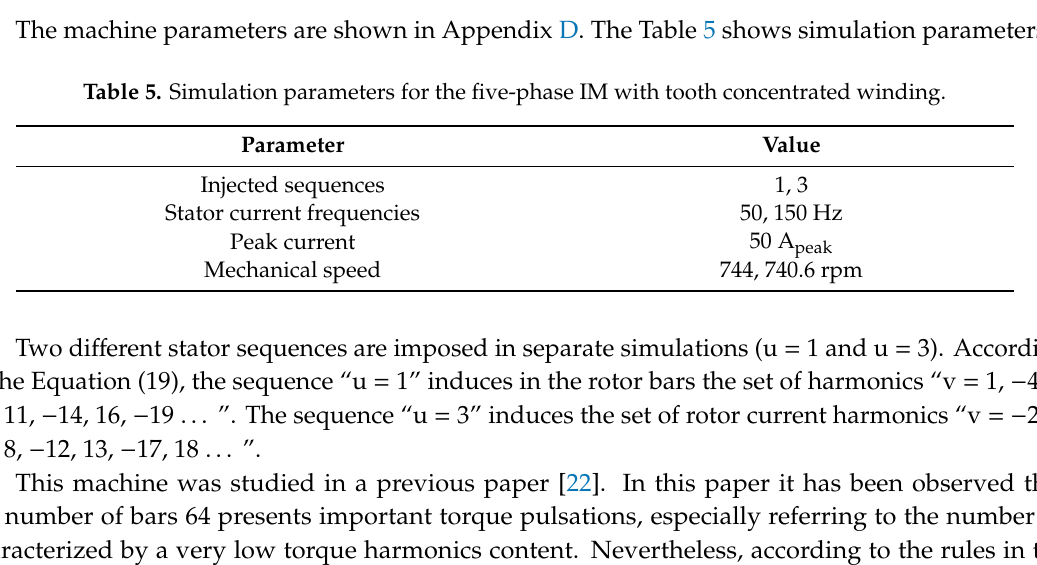
Figure 8. FFT of Finite ‐ Element torque for the five ‐ phase IM with 64 bars. Under sequence “u = 3” (the planes of line (2), Figure 9 are excited).